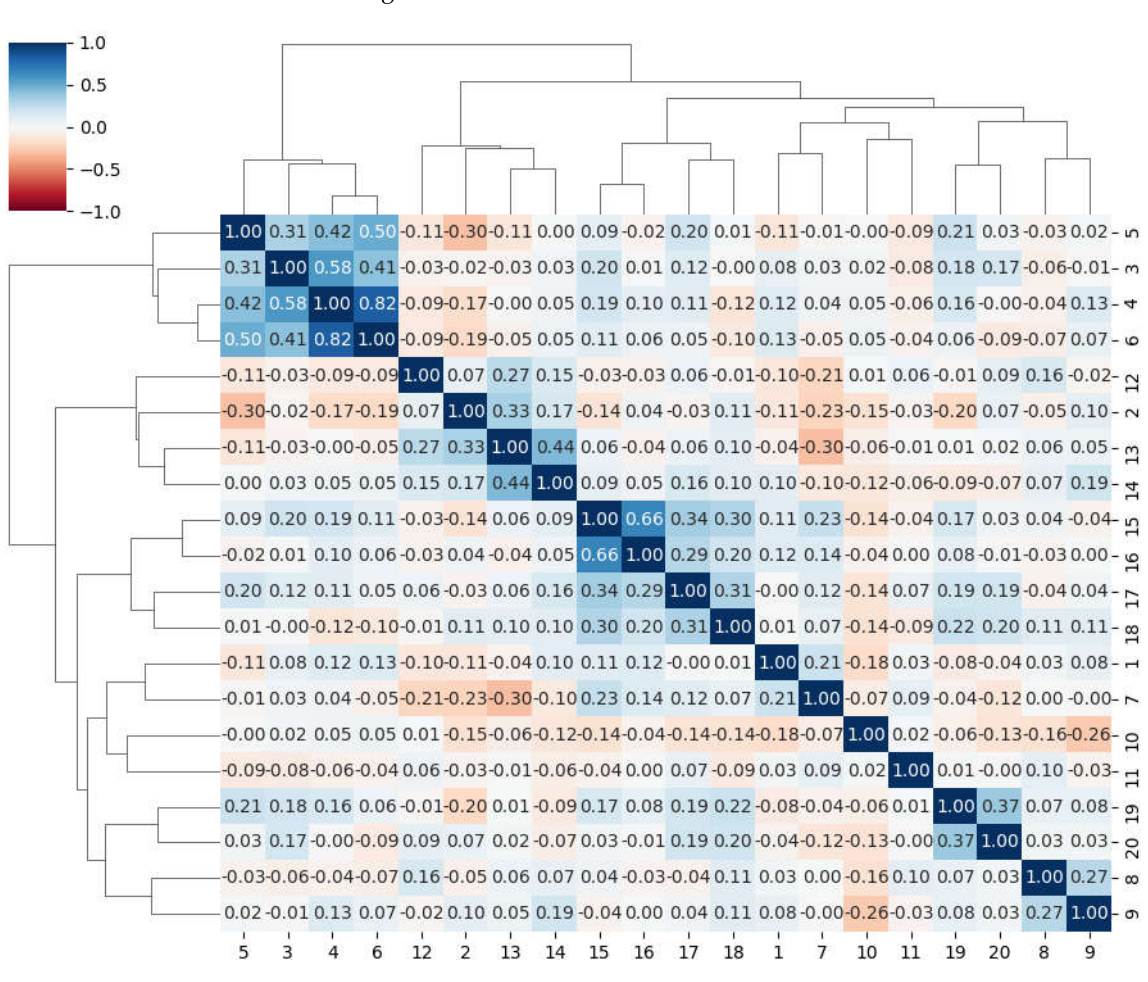
Figure 6. Correlation heatmap considering the question of Table 1.